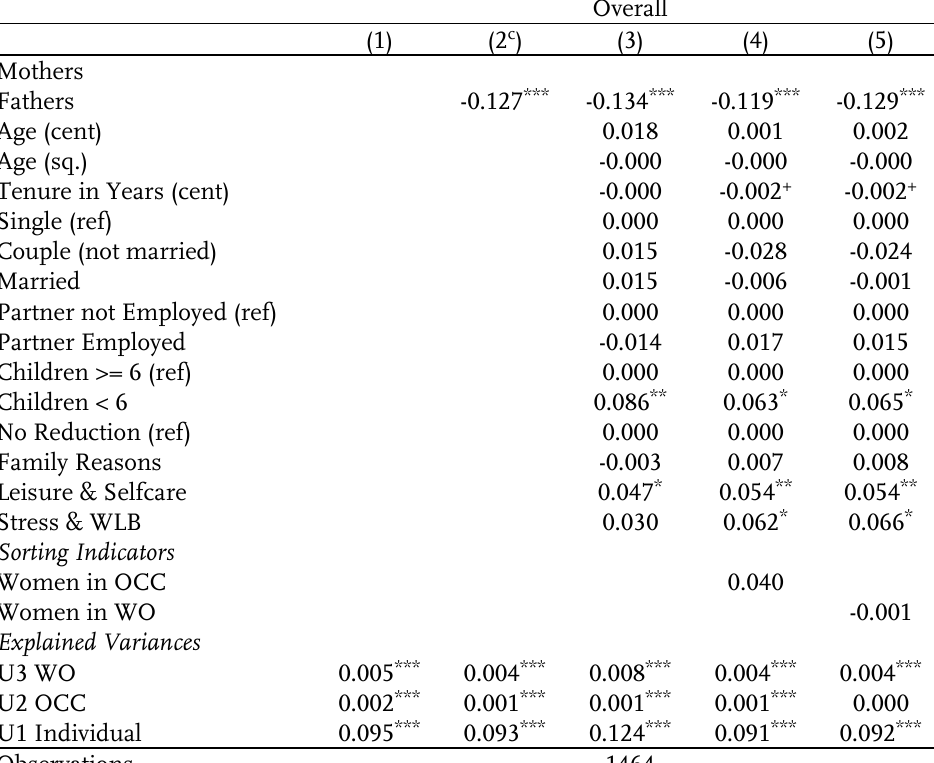
Cross classified multilevel model on reduction of contracted working hours (2 hour